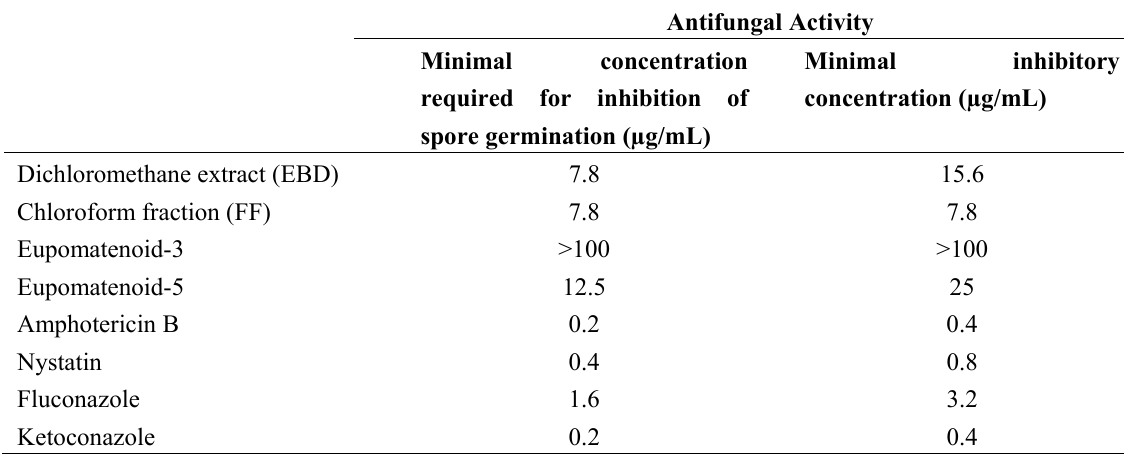
Table 1. Antifungal activity of extract, fraction and isolated compounds of leaves from P. regnellii against T. rubrum.